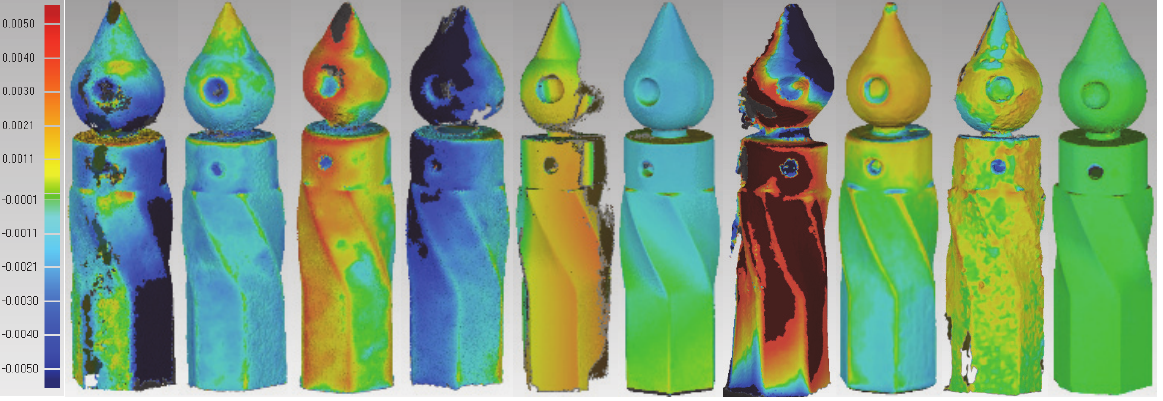
Figure 6. Deviations [m] of the different Testys (3D comparison in Geomagic Studio, test data vs. reference) (f.l.t.r.) – DPI-7 dhp:i T2, DPI-7 LKA T1, DPI-7 HSBO T1, DPI-7 HSBO T2, Artec Spider T1, Mantis F5 T3, Kinect 2 T2, Structure Sensor